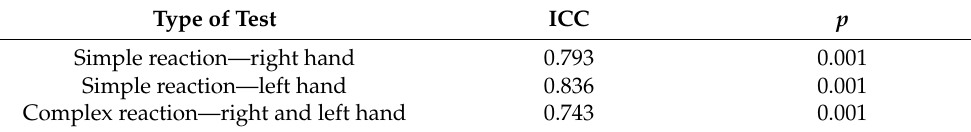
Table 1. Intraclass correlation coefficients (ICC) for computer-based simple and complex reaction tests.